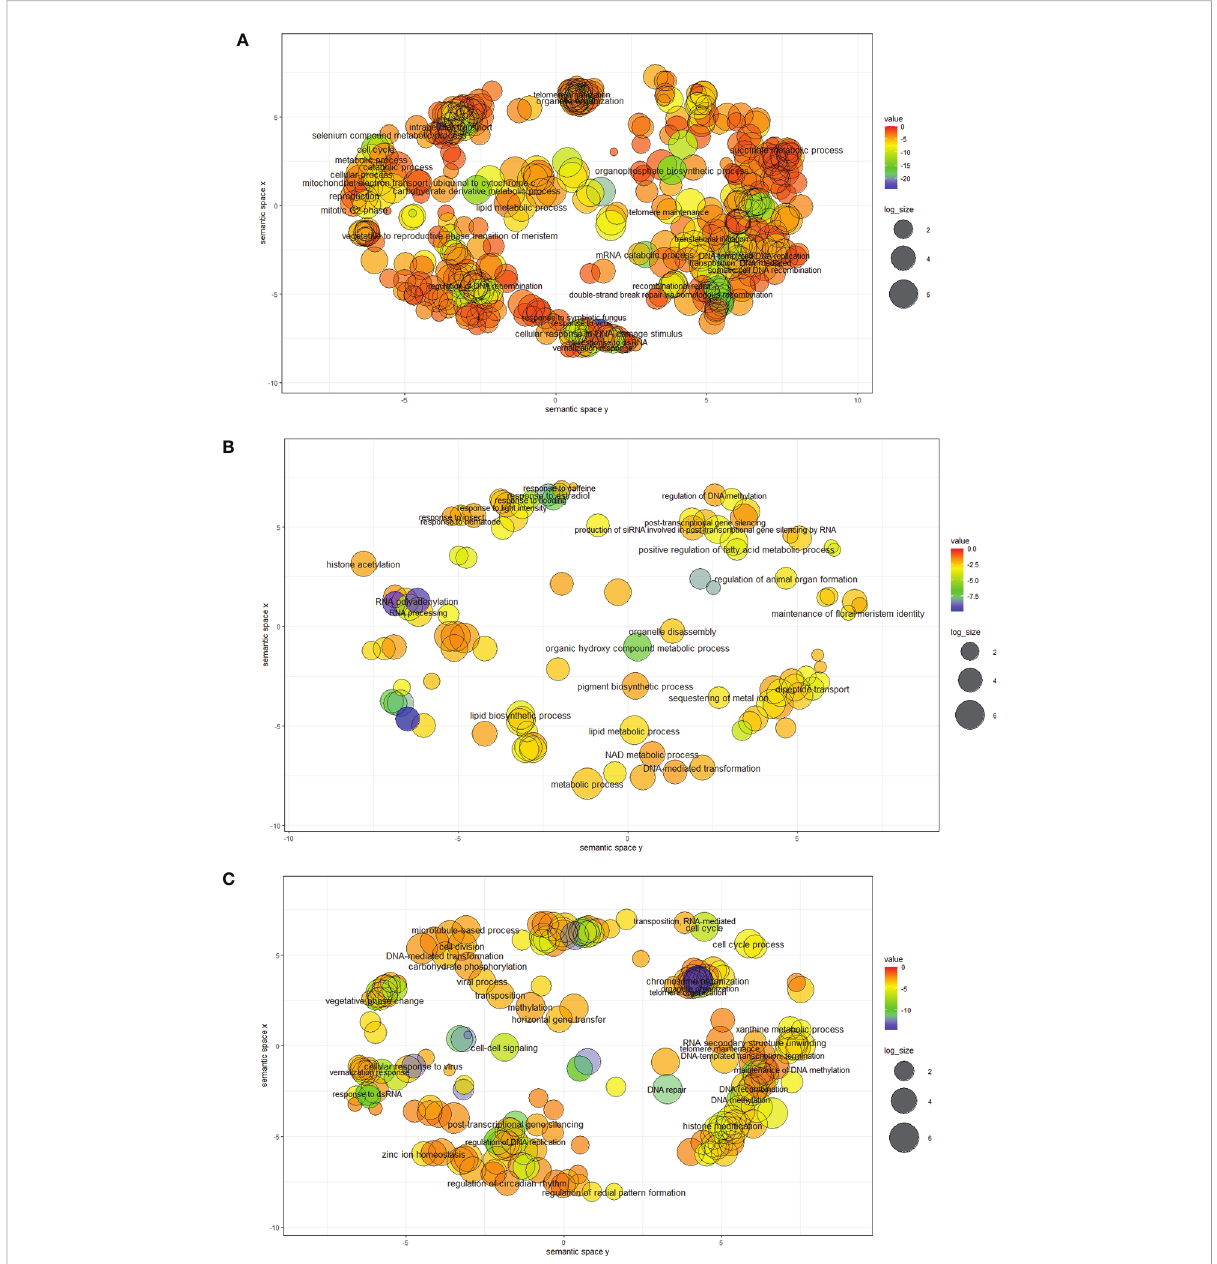
FIGURE 2 Signi fi cantly enriched GO BP (Biological prosses) terms found in GO SEA preformed for triads which include TE insertions from the DTT (A) , DTM (B) and RLC (C) superfamilies (TE codes are based on Wicker et al., 2007). GO SEAs were preformed using AgriGO toolkit with Fisher ’ s exact test (FDR ≤ 0.05). Following the GO SEA, the enriched GO terms for BP for each superfamily were visualized as a scatter plot generated by REVIGO. Closer GO terms in the plot are showing higher semantically similarity to each other. The bubble color indicates the FDR value and the size indicates the frequency of the GO term in the GOA database, bubbles of more general terms are